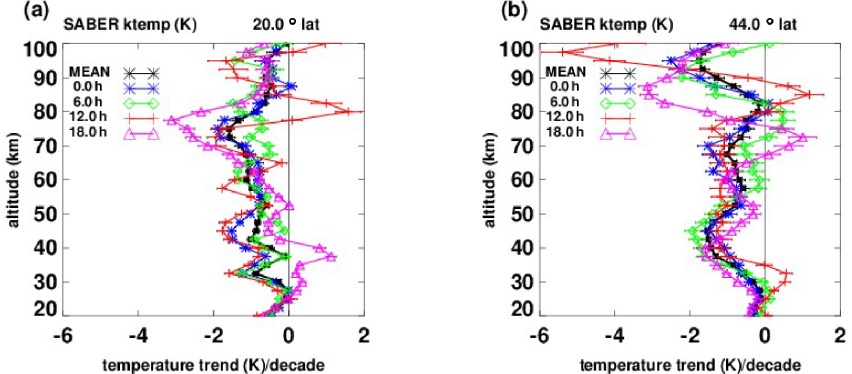
Figure 6. Temperature trends (K per decade) vs. altitude from 20 to 100km at 20 ◦ N (a) and 44 ◦ N (b) . Black: trends based on SABER zonal means over longitude and local time; blue: based on zonal means at 00:00LT; green: 06:00LT, red: 12:00LT, magenta: 18:00LT.